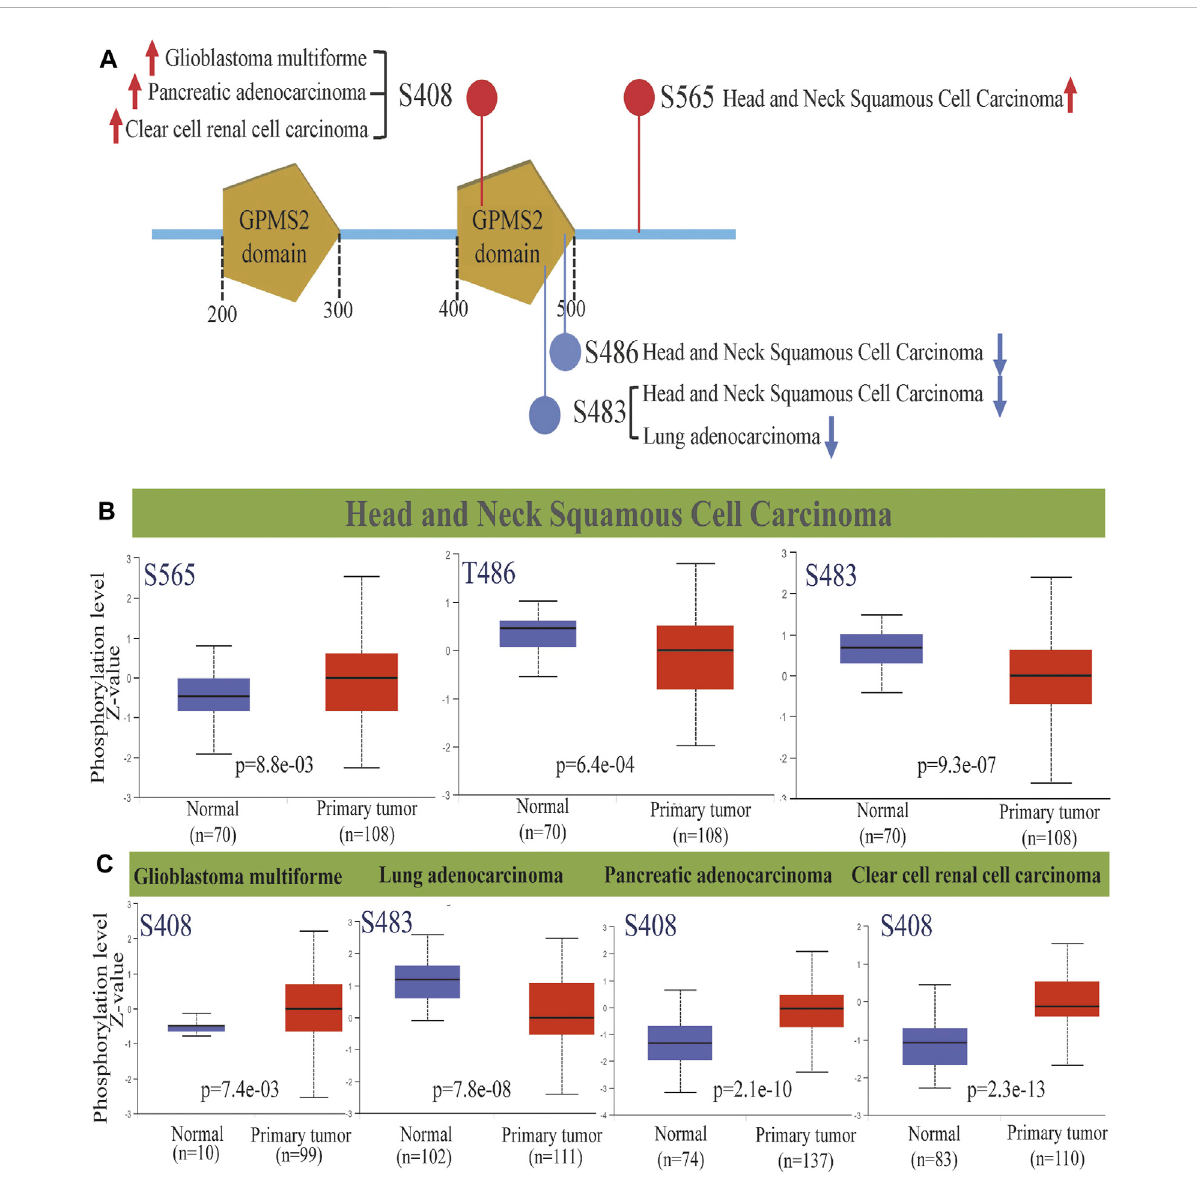
FIGURE 6 GPSM2 protein phosphorylation diagram across cancers. (A) GPSM2 protein phosphorylation sites were detected. (B) Box diagram of GPSM2 - related protein phosphorylation levels in HNSC. (C) Box diagram of GPSM2 -related protein phosphorylation levels in GLMU, LUAD, PAAD, and